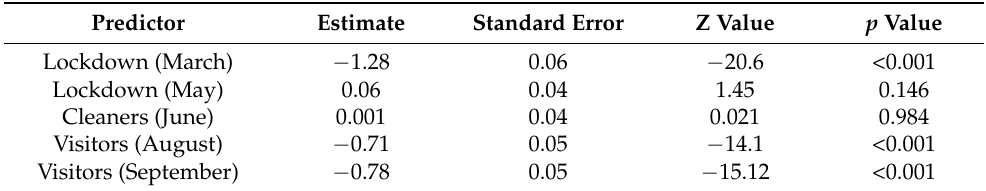
Table 2. Model outputs for Poisson regression for start and end of lockdown, period of time when staff returned and the two months when visitors were present.